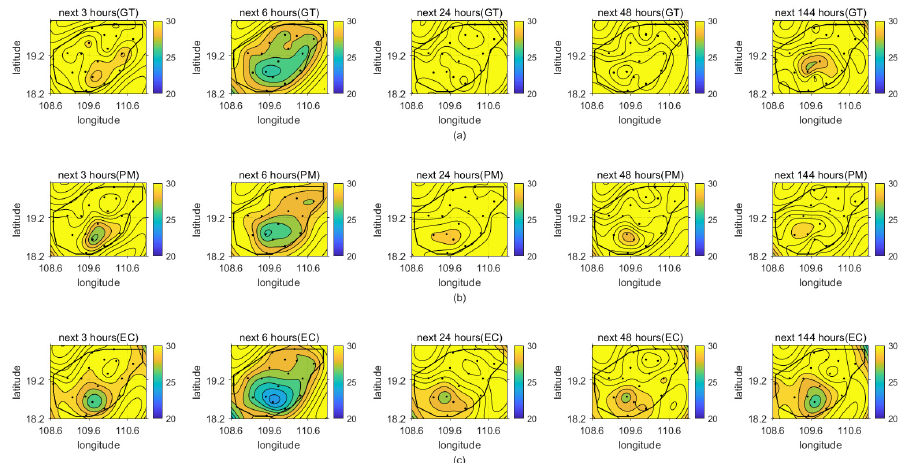
Figure 8. Temperature fields of 18 cities for the next 3, 6, 24, 48, and 144 h: ( a ) real temperature; ( b ) proposed correction; ( c ) ECWMF prediction.